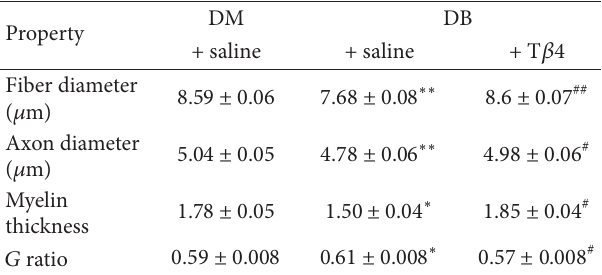
Table 3: Effect of T 𝛽 4 on histomorphometric parameter of sciatic